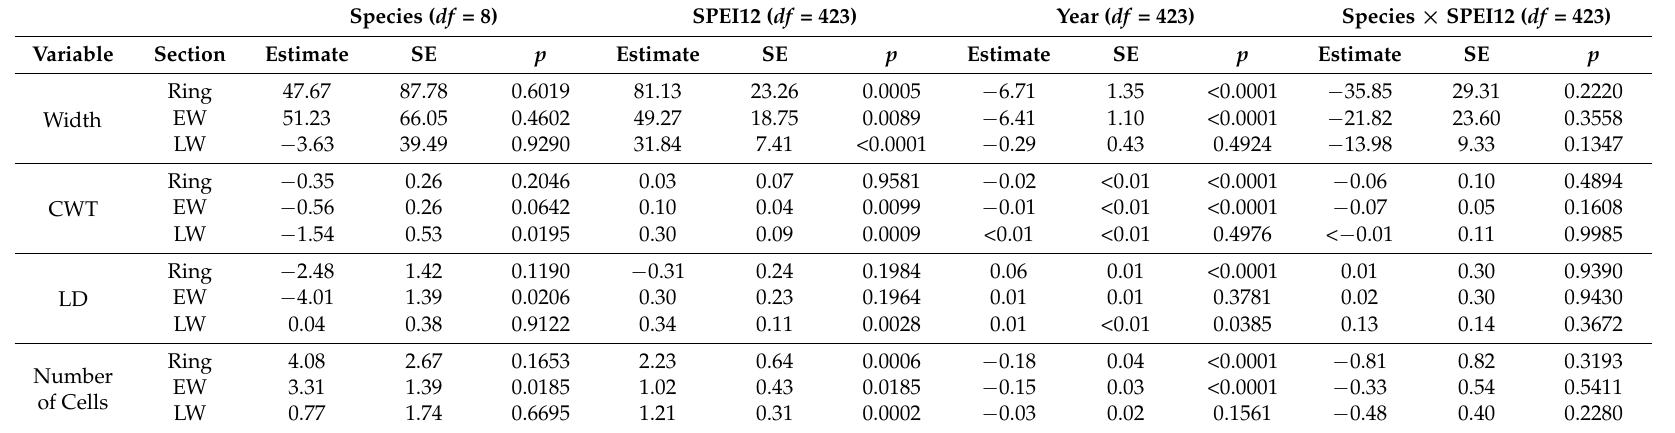
Table 1. Results for the linear mixed-effects models for width of the entire ring, earlywood and latewood, and the total number of cells in the annual ring